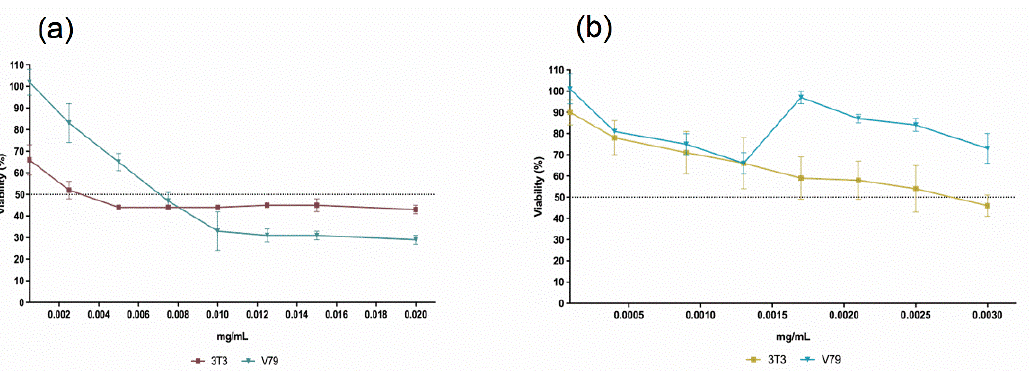
Figure 12. Cytotoxicity evaluation of formulations ( a ) Nano_GER3%/ICAR3% and ( b ) Nano_Control on 3T3 and V79 cell lines.